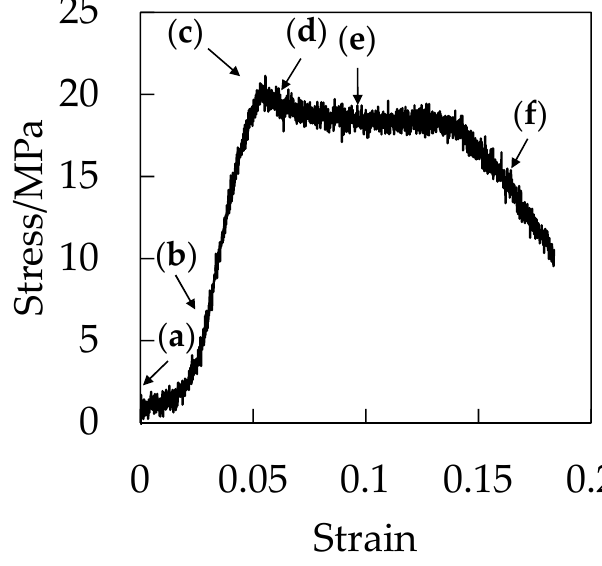
Figure 7. Stress–strain curve of OD-PC during stretching under CO 2 at 5 MPa.